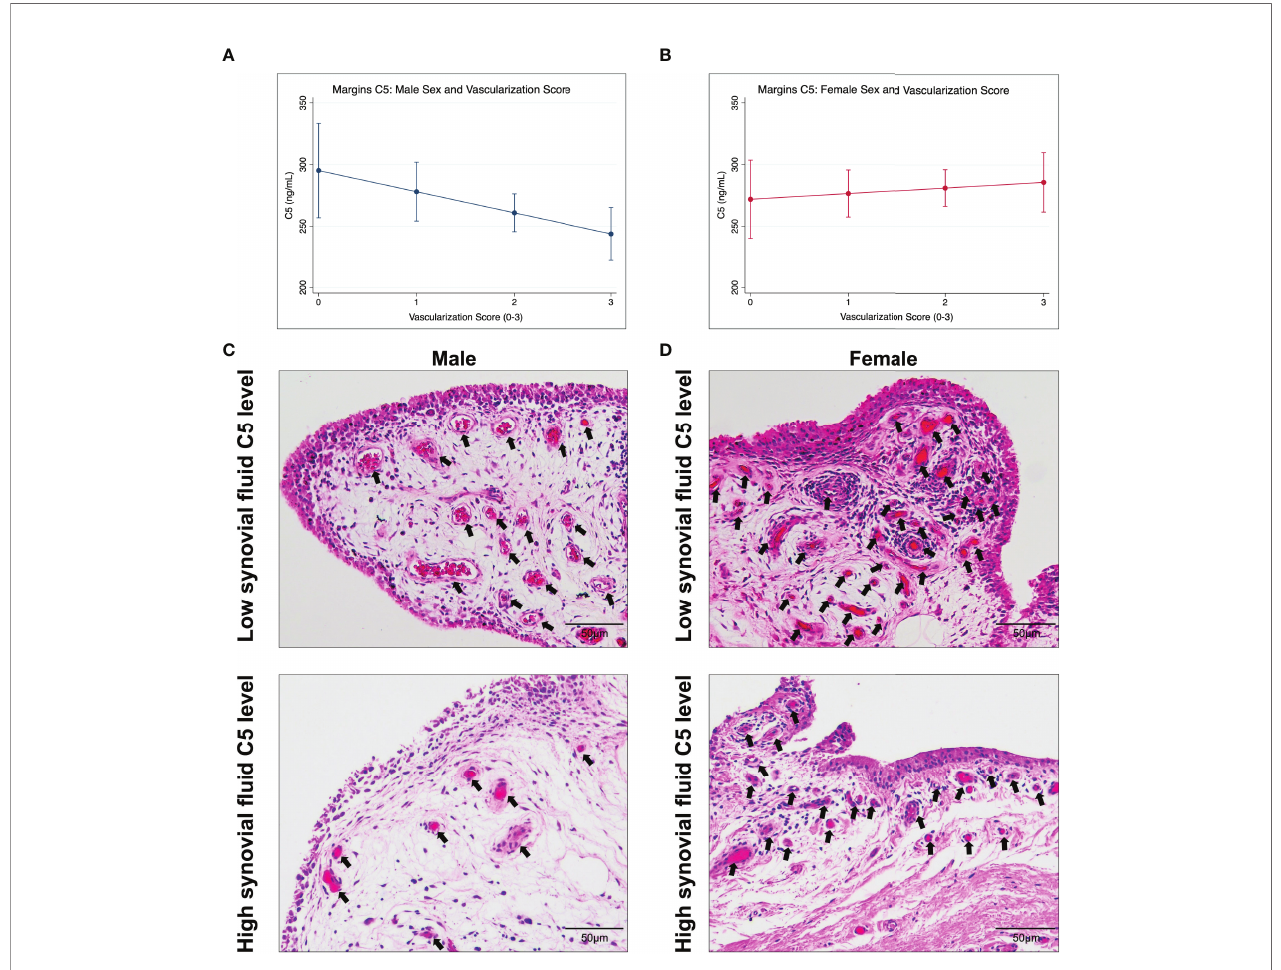
FIGURE 2 | Marginal effects for the association between synovial fl uid C5 levels and median synovial vascularization by sex and representative synovial histopathology. Data shown are estimated marginal means ± 95% CIs for median vascularization score (0-3; none-severe) at C5 concentration (ng/mL) of 100, 200, 300, and 400 ng/mL by (A) male and (B) female sex. Histopathological images of synovium stained with hematoxylin and eosin, representing the C5 and vascularization trend in (C) males, and lack of trend in (D) females. (C) shows synovium from a male with low C5 concentration and high vascularization and from a male with high C5 and less vascularization (arrows). Scale bar 50